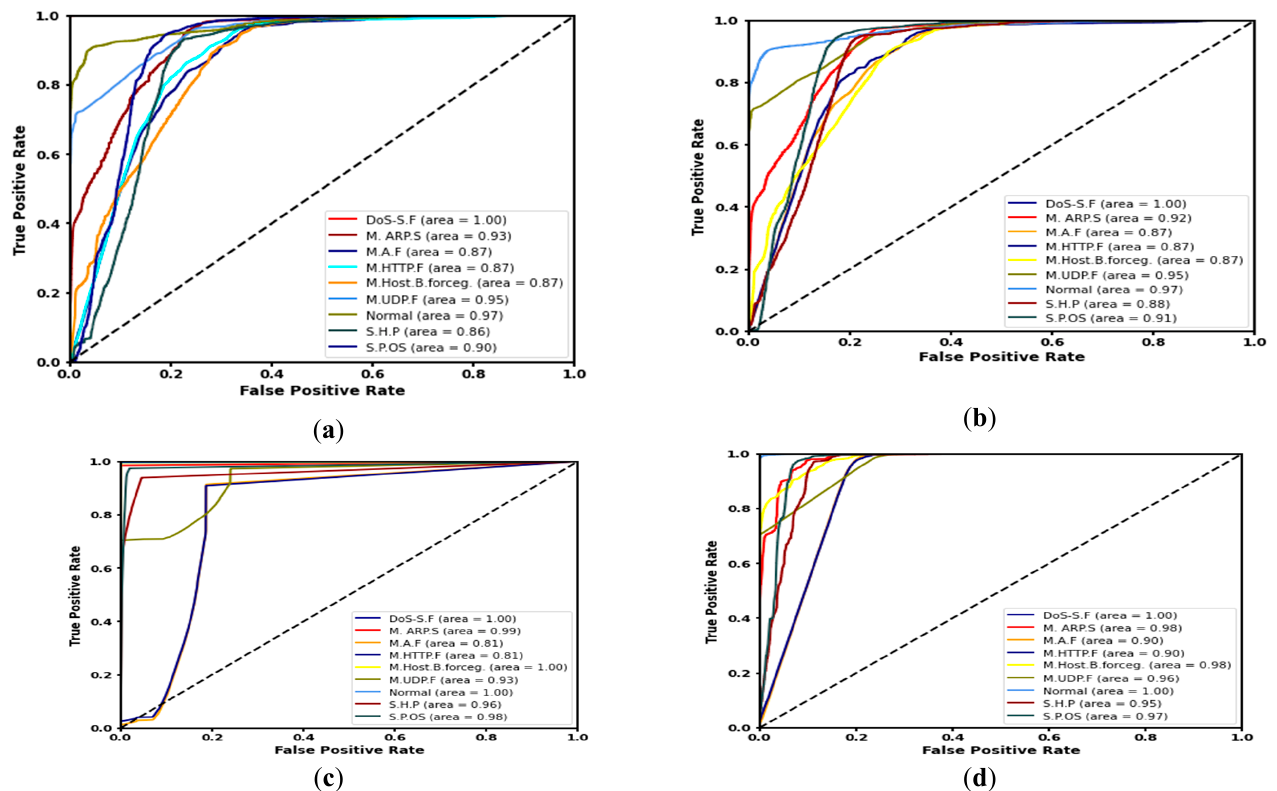
Figure 12. ROC curves for four various ML algorithms ( a ) LR, ( b ) SVM, ( c ) DT, and ( d ) ANN .